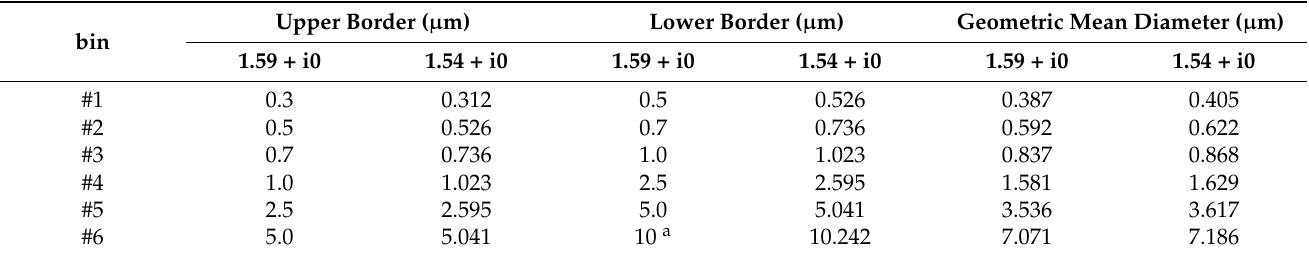
Table 2. Nominal operational bin borders of the OPSS calibrated to mono-disperse PSL particles with a refractive index of 1.59 + i0 and for ambient particles with a refractive index of 1.54 +